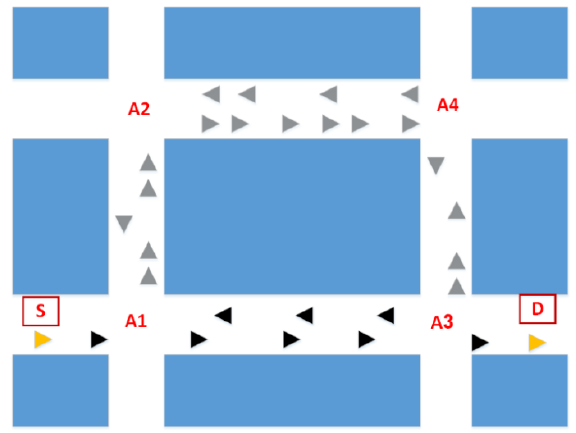
Figure 1. One example of network topology. Figure 2. The path in which the vehicles are highlighted is the optimal route. In fact, the amount of calculated glowworm luciferin is higher on this route.